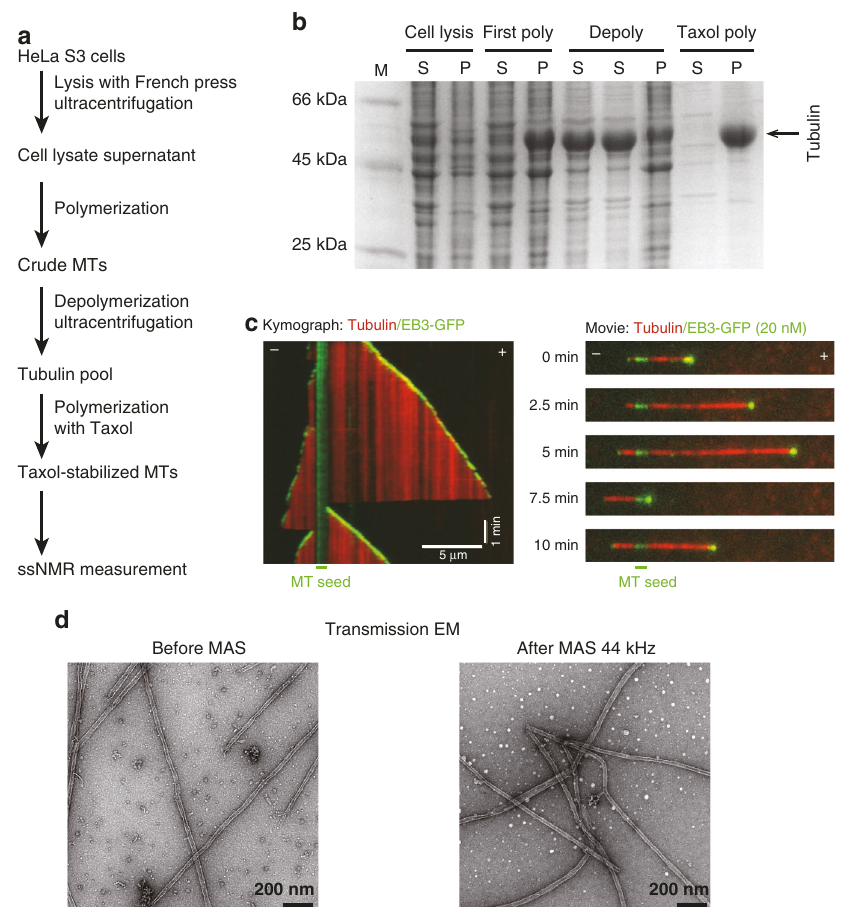
Fig. 1 MT preparation from HeLa S3 cells and sample characterization. a Schematic overview of the sample preparation. b SDS-PAGE analysis from each puri fi cation step. M: protein marker; S: supernatant; P: pellet; fi rst poly: fi rst polymerization; depoly: depolymerization; Taxol poly: polymerization with Taxol. The uncropped gel is provided as a Source Data fi le. c Functional characterization of puri fi ed HeLa S3 tubulin. Kymograph (left) and movie stills (right) of an in vitro polymerized MT imaged for 10 min on a TIRF microscope correspond to Fig. S1C. Time points and MT plus ( + ) and minus ( − ) ends are indicated. d Characterization of morphology of HeLa MTs before and after MAS NMR experiments by